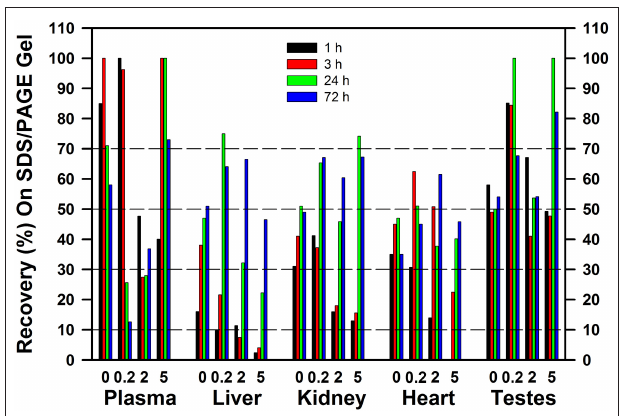
FIGURE 11 | Schematic diagram of Se metabolism to selenoproteins. Underlined are the five tracer selenocompounds administered in these experiments. Selenate is reduced to selenite; selenite can react with GSH to form GSSeSG, which is then further reduced to selenide. SeMet is degraded via transulfuration to Sec which can be metabolized to selenide, or SeMet is degraded via transamination to methaneselenol and then selenide. Alternatively, SeMet can be incorporated into general body proteins as a methionine analog. SeBetaine is degraded to release methaneselenol. Selenide is the precursor used for selenoprotein incorporation, as assessed by SDS/PAGE in these studies. Metabolites not detected by SDS/PAGE include the low MW selenosugars, high-MW “selenosugar-decorated” proteins, and other unknown